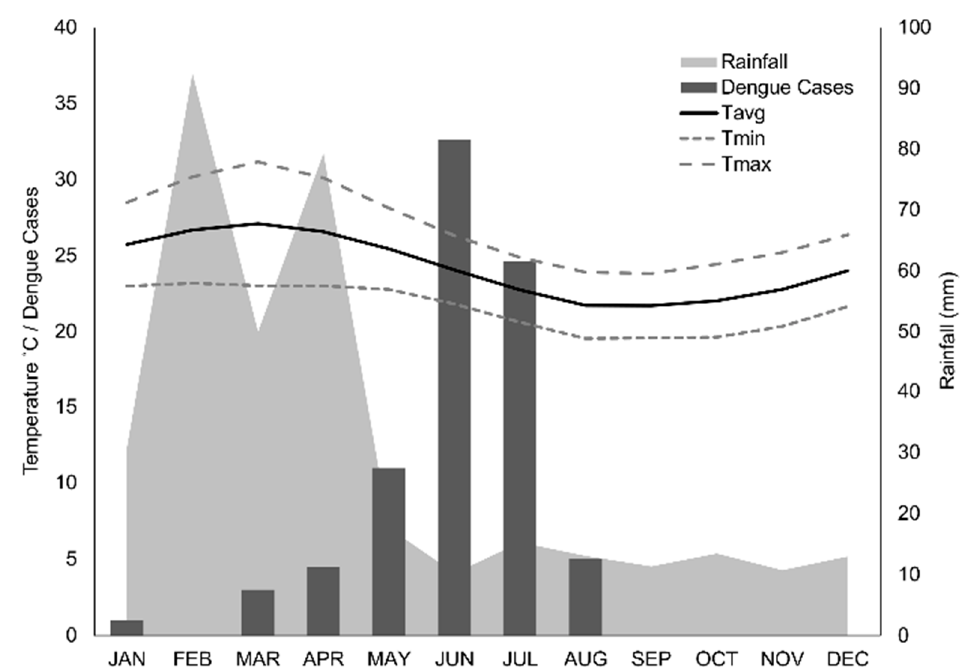
Figure 3. Seasonality of dengue transmission and climate in Puerto Ayora (2000–2012). We show average dengue cases reported by month, average monthly rainfall, and average monthly temperature (Tavg), with average minimum (Tmin) and maximum (Tmax) monthly temperature. Note that dengue cases appear to peak following the peak of temperature and rainfall, across the same 12-year time period.